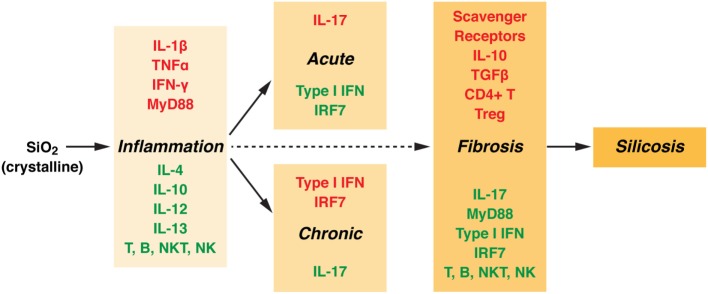
Molecular and cellular components involved in silica-induced inflammation and fibrosis. Silicosis is marked by inflammation and fibrosis with the formation of nodular lesions in the upper lobes of the lungs. The collagen containing silicotic nodules are a specific response to crystalline silica. However, the cellular and molecular components responsible for the inflammatory and fibrotic responses are not the same. Components required for inflammation (acute or chronic) and fibrosis are highlighted in red, while those not essential have been highlighted in green (see text for details). TNF, tumor necrosis factor; IFN, interferon; MyD88, myeloid differentiation primary response gene 88; IL, interleukin; NK, natural killer; NKT, natural killer T cell; IRF, interferon regulatory factor; TGF, transforming growth factor.